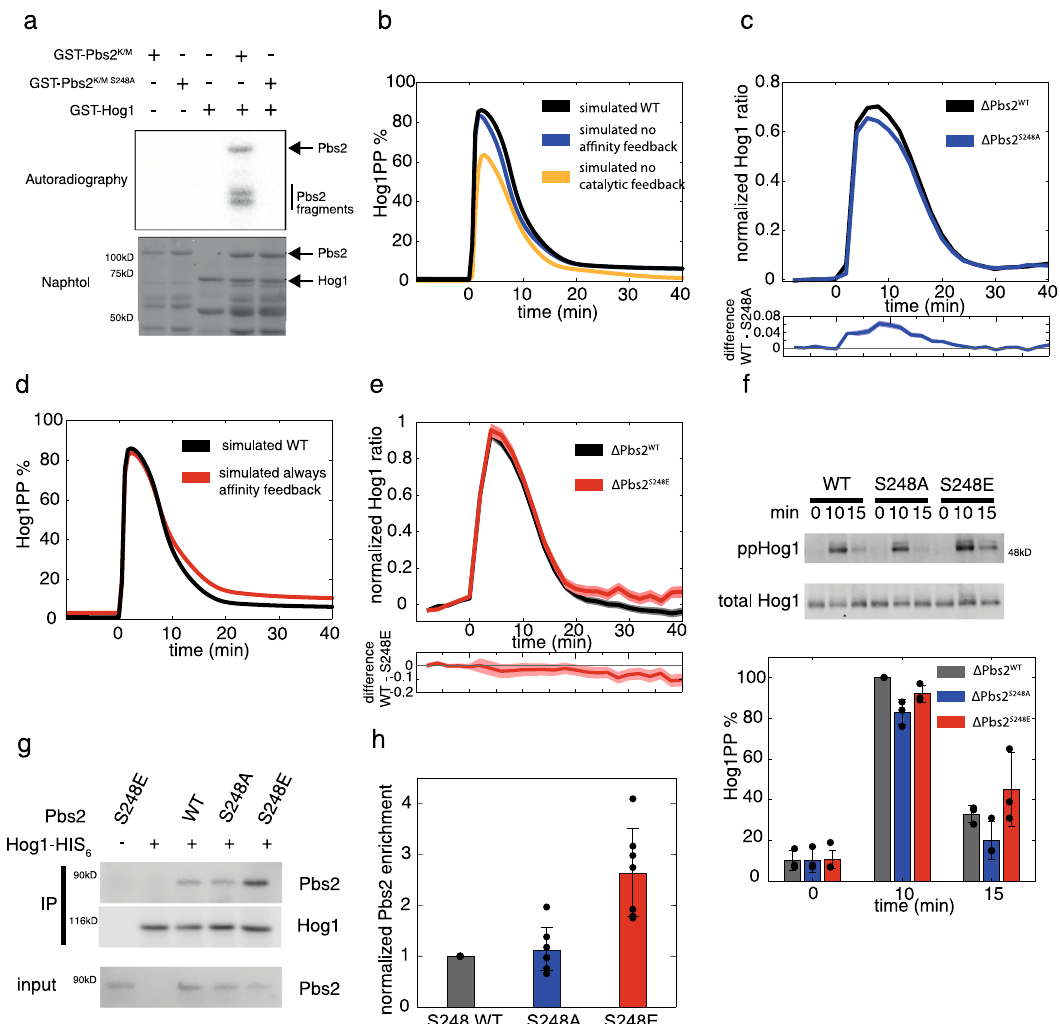
Fig. 5 | Pbs2-S248 is phosphorylated by Hog1 in vitro and affects af fi nity feed- back of Hog1 activation in vivo. a Pbs2 is phosphorylated in vitro by Hog1 at Ser248. Recombinant catalytically inactive GST-Pbs2 K/M proteins were puri fi ed from E.coli andincubatedwithGST-Hog1puri fi edfromNaCltreatedwildtypeyeast (where indicated) in kinase buffer containing ATP. Pbs2 K/M or Pbs2 K/M S248A was then added in the presence of radioactive ATP. Phosphorylated proteins were resolved by SDS – PAGE, stained (lower panel) and dried before detection by auto- radiography (upper panel). b Simulated time lapse of the double phosphorylation of Hog1 upon addition of 0.4M NaCl after 500s. The dynamics simulated by the best fi tting model with mixed phosphorylation mechanism (black line) were declared as wild type and compared to the simulated time course by the same model with either the af fi nity component (blue line) or the catalytic component (yellow line) of the positive feedback on Pbs2 abolished. c Data are presented as mean Hog1 nuclear to cytosolic ratio±SEM of a Δ Pbs2 WT strain (black line) with n =4620 cells over three independent experiments and a Δ Pbs2 S248A strain (blue line) with n =5103 cells over three independent experiments upon addition of 0.4M NaCl at time point 0. The lower panel shows the difference of the mean of Δ Pbs2 WT and Δ Pbs2 S248A and thestandarderrorofthemean. d Simulatedtimelapse